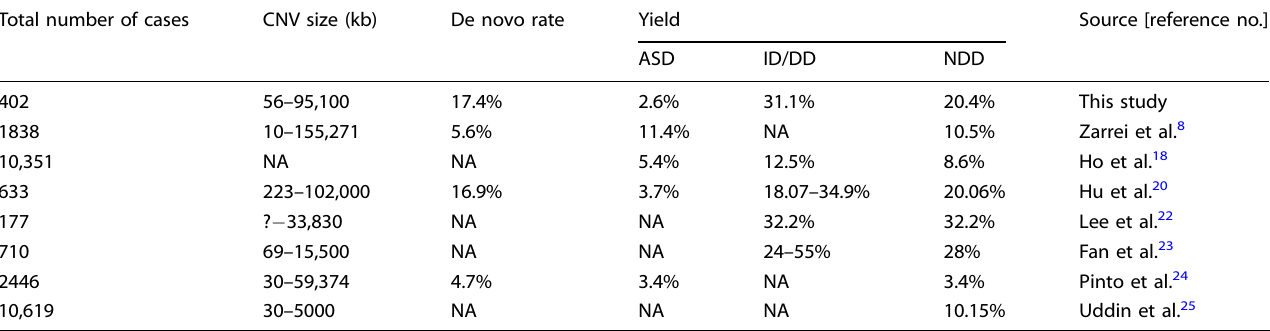
Table 4. Comparison of diagnostic yield CNVs with different